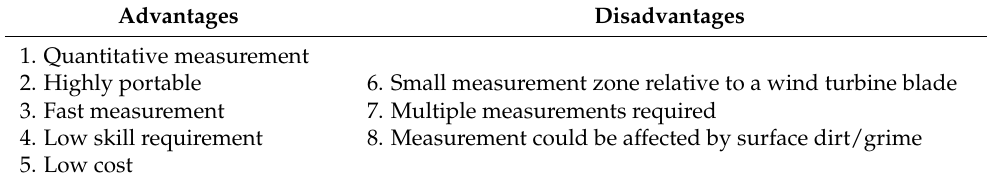
Table 1. Advantages and disadvantages of using a glossmeter to measure wind turbine blade